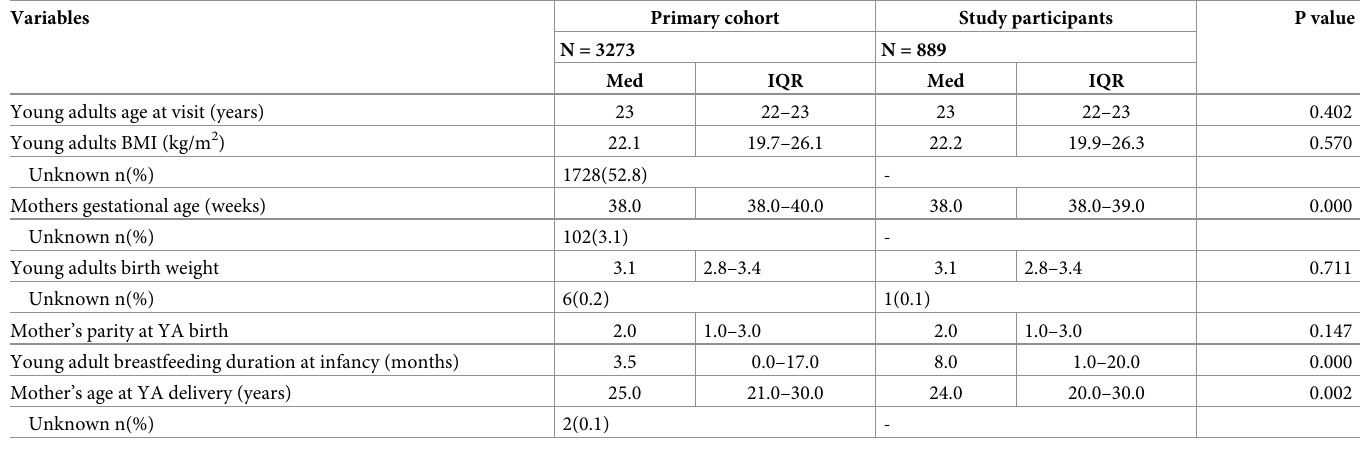
Table 2. Comparison between primary cohort and study participants (continuous